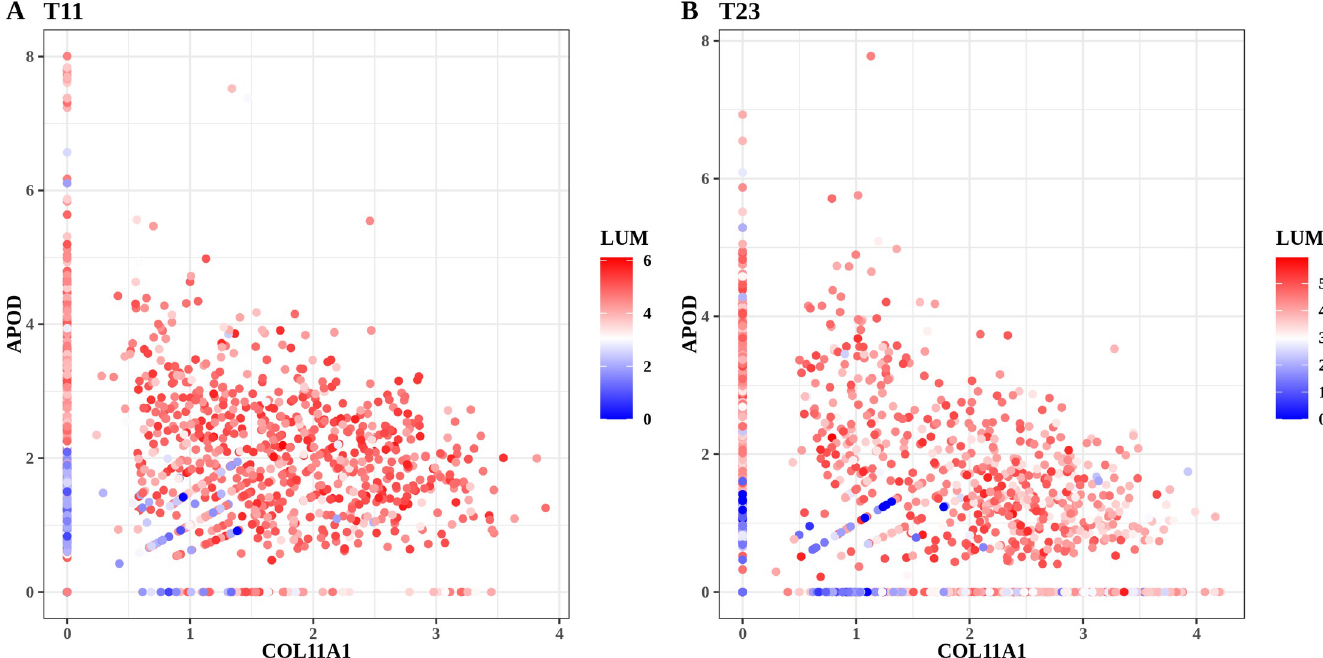
Fig 1. Scatter plots for fibroblast-rich samples for patients (A) T11 and (B) T23. Each dot represents a mesenchymal cell identified in the sample. The x- and y-axis denote the expression levels of COL11A1 and APOD , respectively. Dots are colored for the expression of fibroblastic marker LUM . The expression unit is the normalized log-transformed value from the count matrix (Materials and